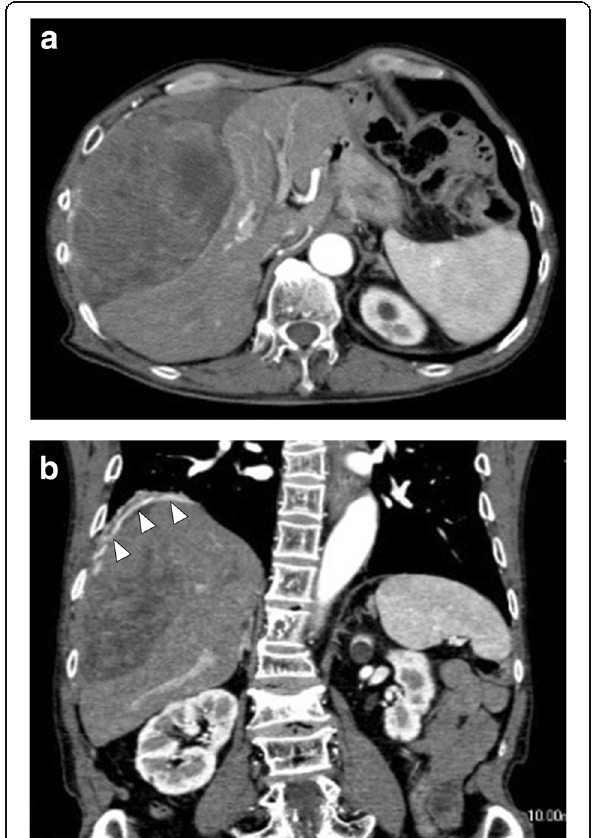
Fig. 1 Computed tomography image showing a large subphrenic tumor. The heterogeneously enhanced tumor was well demarcated from the liver ( a ). The feeding artery originated from the diaphragm (arrowhead) ( b )